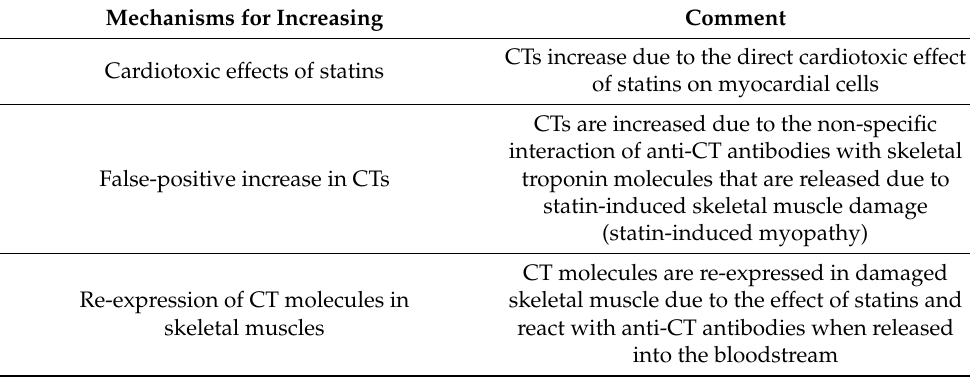
Table 2. Possible mechanisms for increasing CTs level after taking